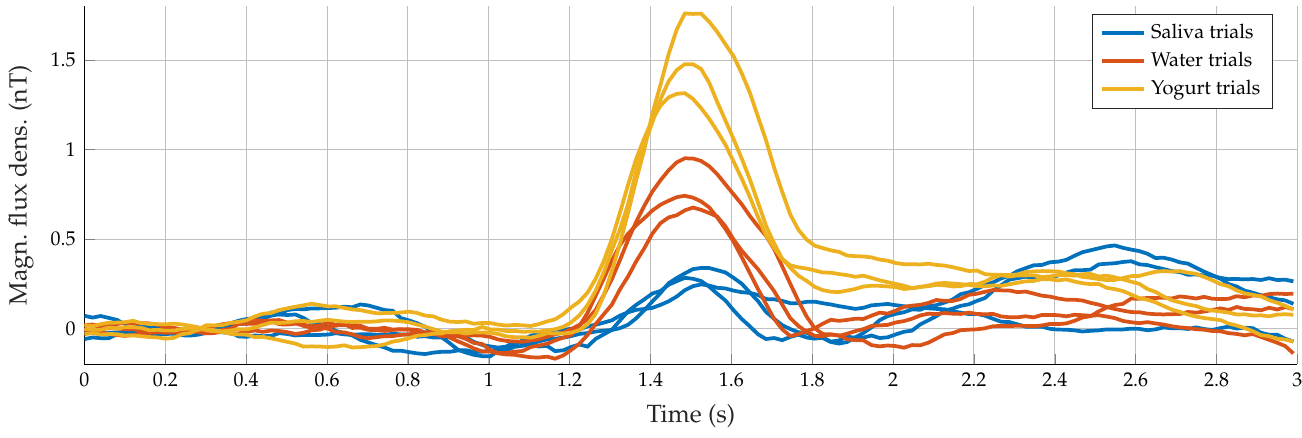
Figure 4. Example signals of all swallowing trials with different liquids for Subject